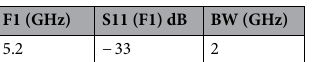
Table 3. Electrical specification of Antenna3.